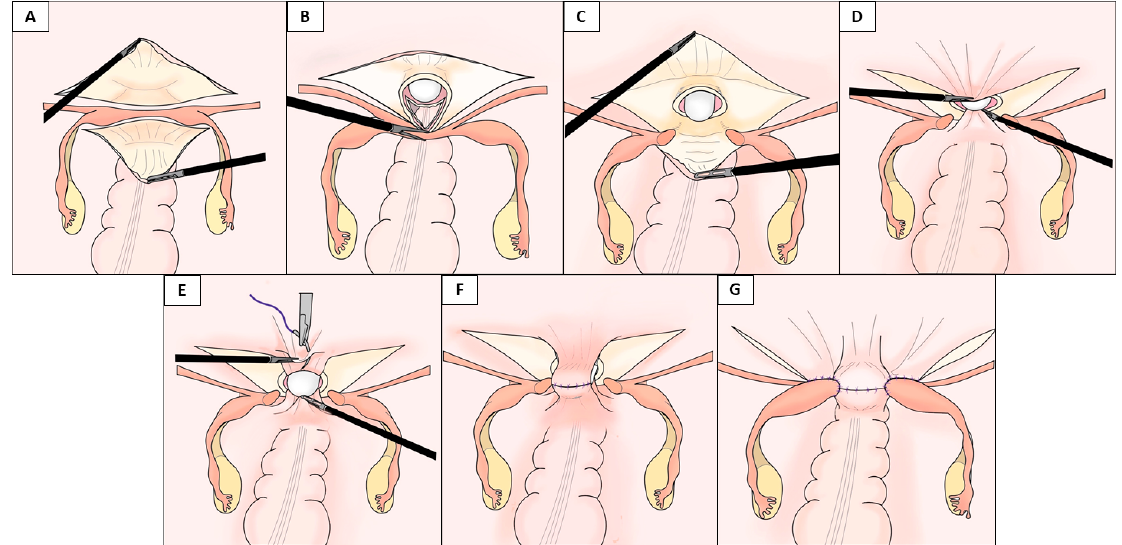
Figure 1. The Kisu modification. This schema shows the laparoscopic creation of a neovagina using a modified peritoneal pull-down technique with uterine strand incision. ( A ) The anterior and posterior peritoneal flaps (the peritoneum in the supravesical pouch and pouch of Douglas) are dissected extensively. ( B ) A transverse incision below the uterine strand serves as the opening of the neovaginal apex. ( C ) The uterine strand is divided via a longitudinal incision. ( D ) The anterior and posterior peritoneal flaps are pulled down through the neovaginal canal and sutured to the neovaginal introitus. ( E ) The neovaginal apex is created by suturing between the supravesical and suprarectal peritoneum at the target neovaginal length. ( F ) The neovaginal apex is shown before suturing the incised uterine strand to the lateral sides of the neovaginal apex. ( G ) The uterine strands provide additional structural support for the neovaginal vault.